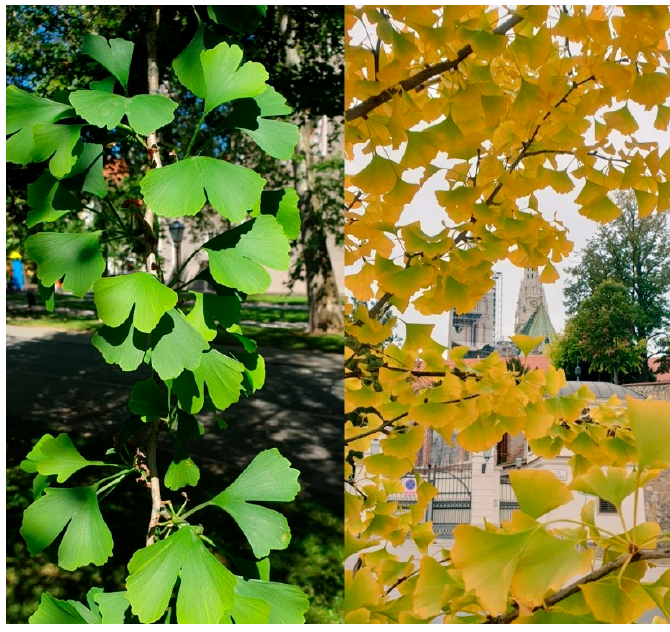
Figure 2. The color of young ( left ) and mature ( right ) G. biloba